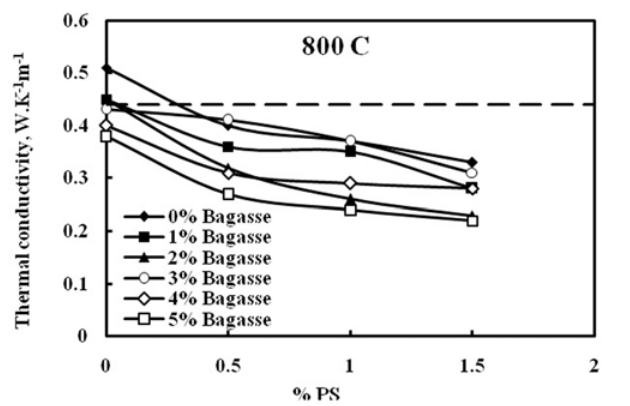
Figure 15. Effect of percent PS and Bagasse addition on thermal conductivity at 800 o